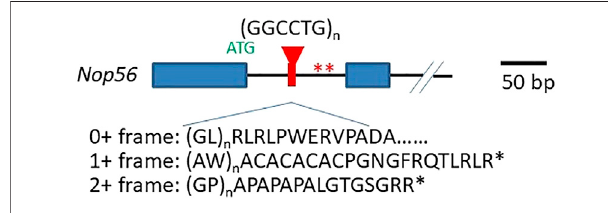
FIGURE 1 | Structure of GGCCTG repeats and its surrounding sequences. The relative location of the repeat expansion in the Nop56 gene and the unconventional translation products from all reading frames on the sensetranscriptareshown.Exon1andexon2areshownasclosedblue boxes,andtheblacksolidlineindicatestheintrons.Therepeatsareinred.The Nop56 start codon ATG (in green) and the two stop codons in frame of unconventional translation producing AW and GP dipeptide repeats are indicated with two asterisks (in red). The schematic of the Nop56 gene is drawn on scale with the 50 bp length showed on the